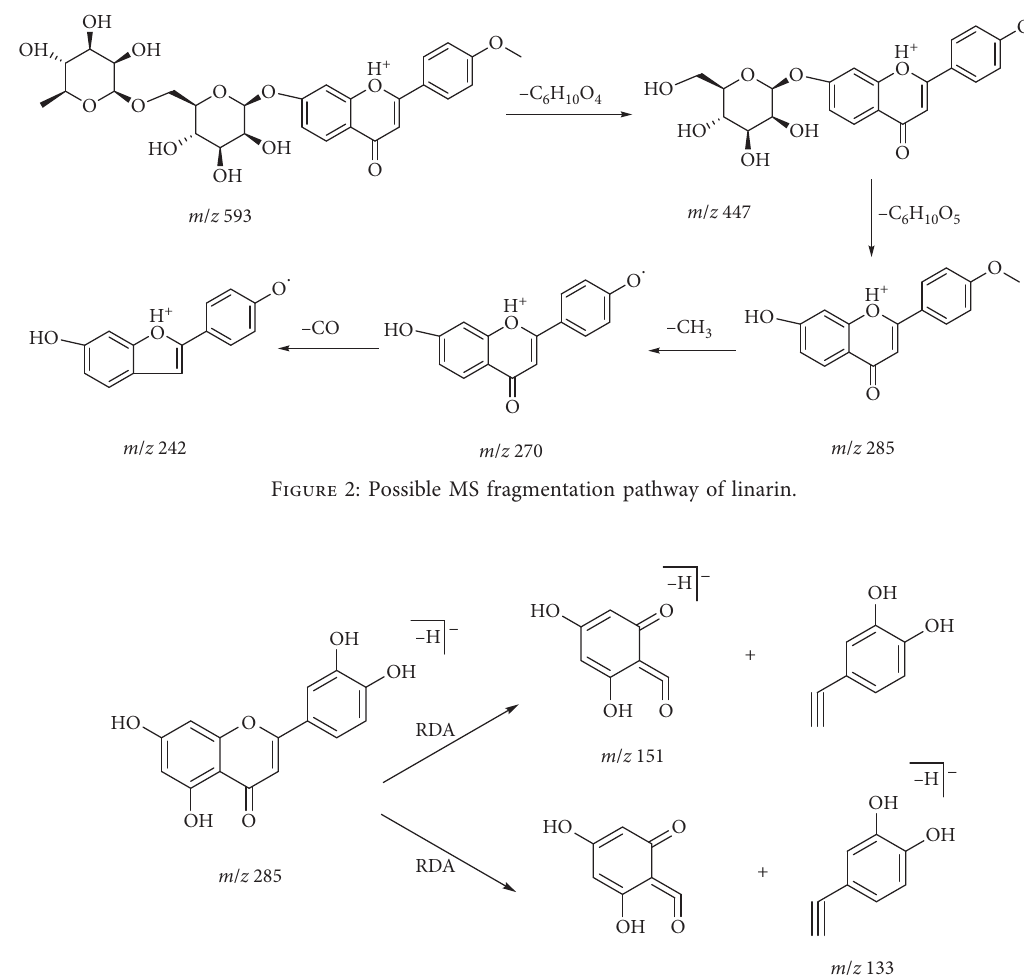
Figure 3: Possible MS fragmentation pathway of luteolin.